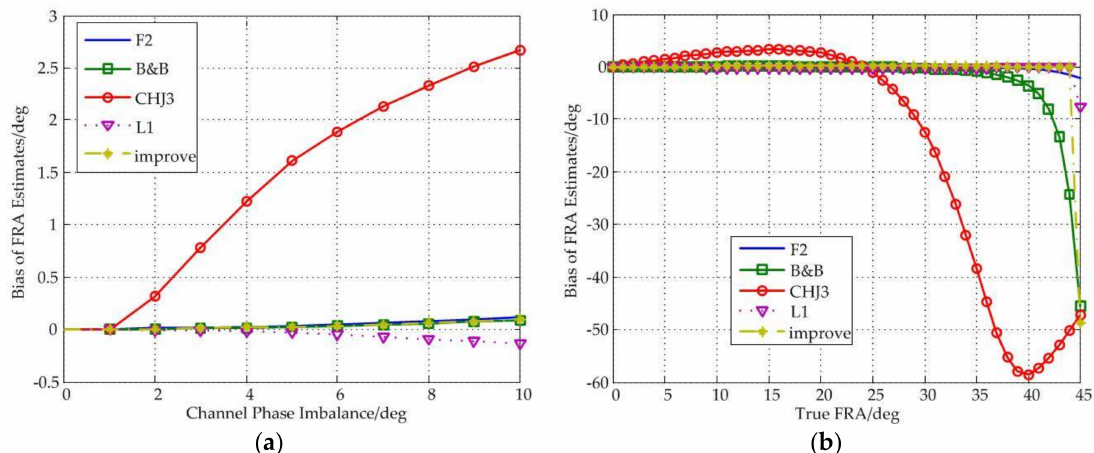
Figure 4. ( a ) Bias of FRA estimates as a function of channel phase imbalance under different estimators; ( b ) Bias of FRA estimates as a function of true FRA under different estimators.